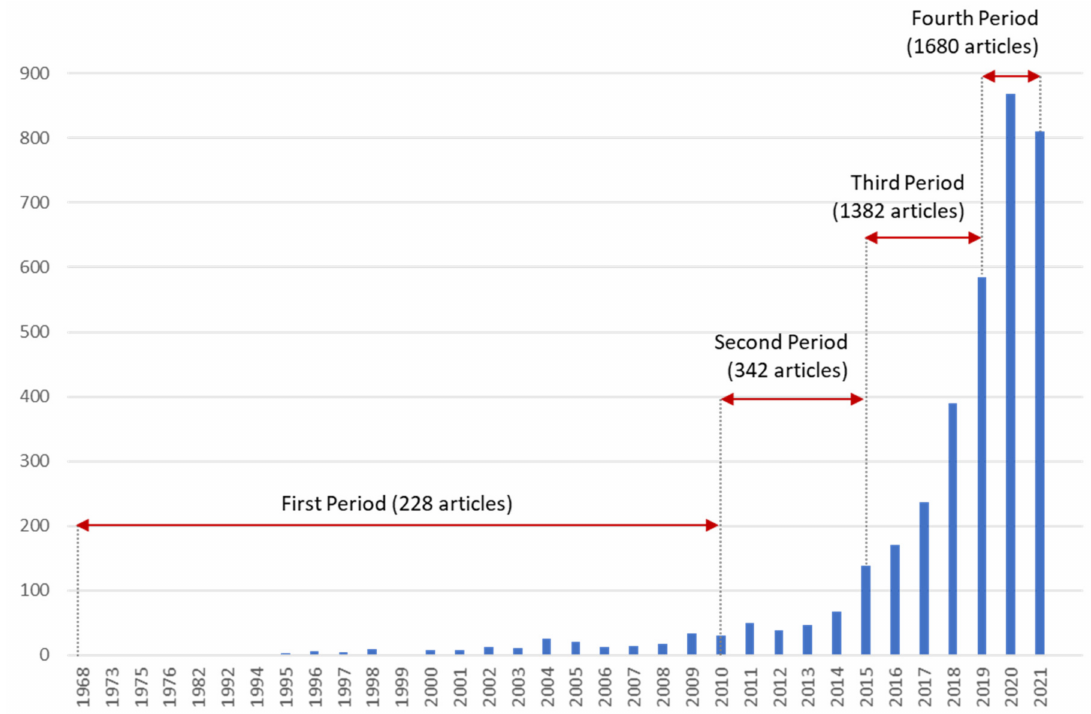
Figure 1. Publication count by year from 1968 to 2021. Illustration by